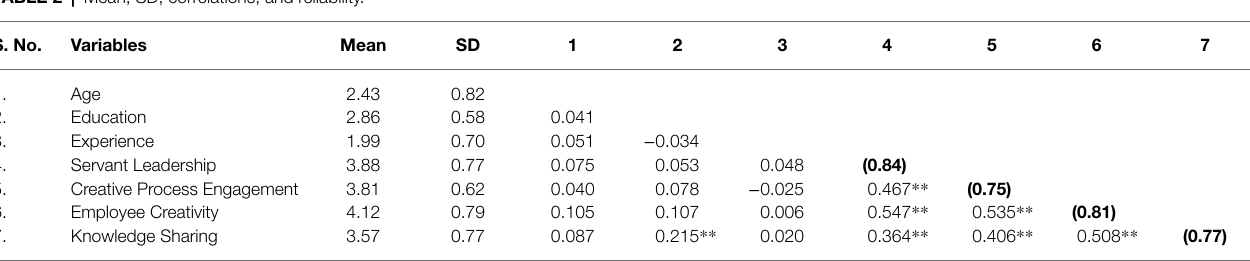
TABLE 2 | Mean, SD, correlations, and